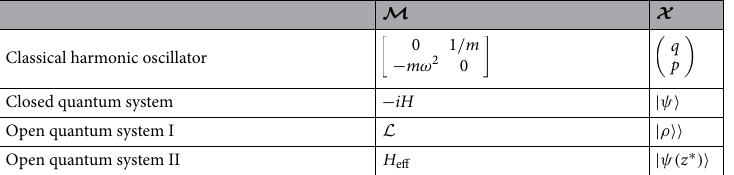
Table 1. A list of examples of linear dynamical equations in physics. (1) Hamiltonian mechanics for classical harmonic oscillator model, where p and q are generalized coordinates and momentum. (2) Schrödinger equation for closed quantum system. (3) Liouville equation for open quantum system 35 , where L is a Liouvillian super- operator, where ρ is the density matrix of the system. For a d -dimensional system, | ρ �� ≡ (ρ 1 , ρ 2 , . . . , ρ d 2 ) ′ . In this case, the dimensionality of X is n = d 2 and | A ( t ) �� ≡ P ( t ) | A ( t ) �� A ( t ) | in normal representation. (4) Stochastic Schrödinger equation for open quantum system, e.g., the quantum-state-diffusion equation, where z ∗ ) � ≡ � z | � � is a state of system obtained by the inner H eff is the non-Hermitian effective Hamiltonian and | ψ( product of a stochastic environment coherent state | z � and the whole system state | (cid:31) � 28–30